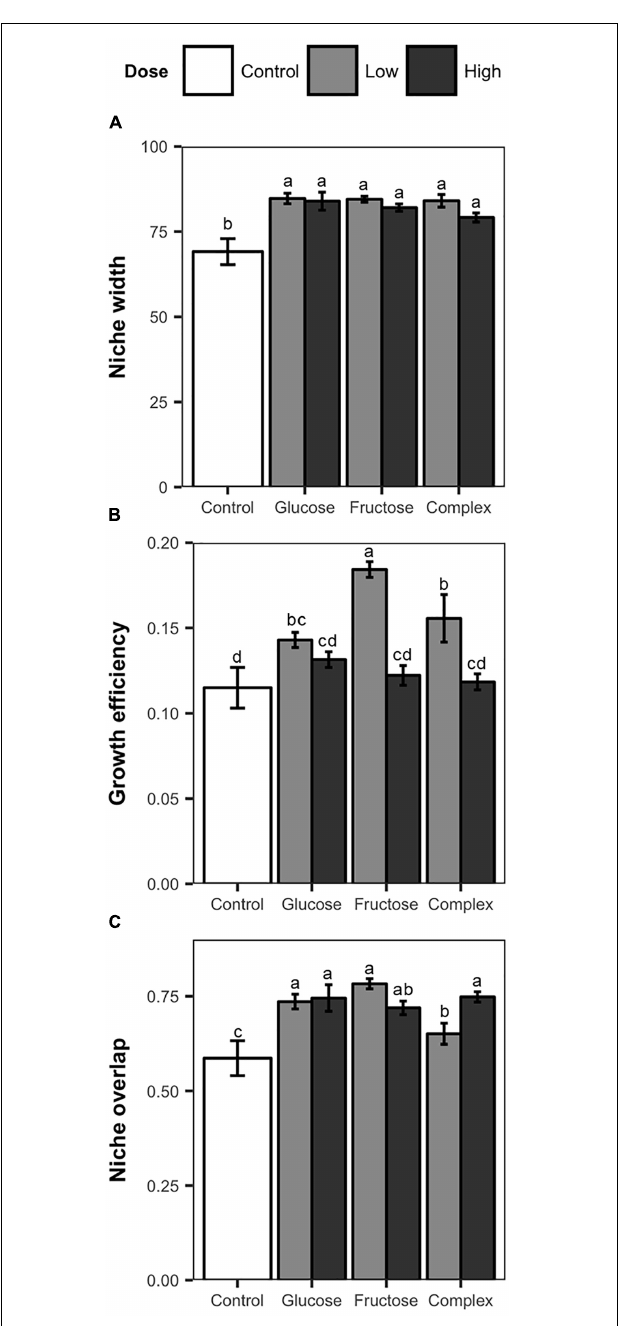
FIGURE 2 | Nutrient use measurements, including mean niche width (A) , mean growth efficiency (B) , and niche overlap (C) of Streptomyces isolates from carbon-amended and non-amended soils after 72 h incubation period based on the utilization of 95 distinct carbon sources determined using Biolog SF-P2 plates. Mean niche width represent the number of substrates utilized. Mean growth efficiency was calculated by dividing total growth (sum of the absorbance values over all nutrients used) by niche width for each isolate. Mean niche overlap was determined for all possible pairwise Streptomyces isolate combinations from same treatment. Within each figure, different letters above the bars indicate significant differences among treatments. Bars sharing at least one letter are not significantly different from each other (ANOVA and LSD test, p < 0.05). Error bars represent standard